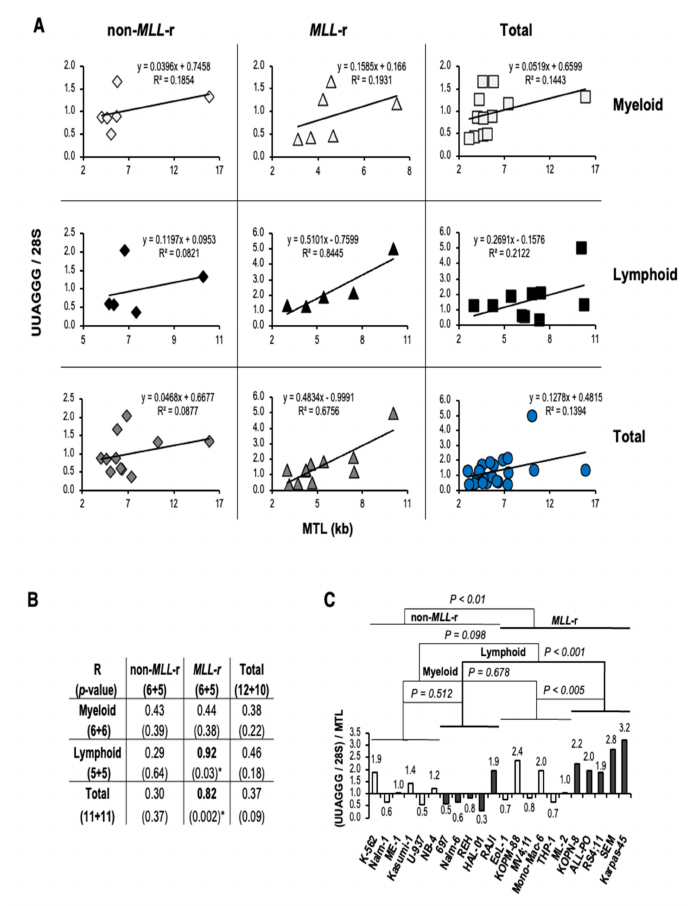
Figure 4. UUAGGG repeat-containing RNA levels in MLL-r ALL correlate with telomere length and reflect increased levels of TERRA. ( A ) Linear correlation analysis between UUAGGG repeat- containing RNA level per transcriptome (UUAGGG/28S) and mean telomere length (MTL) in leukemia cell lines of myeloid and lymphoid lineage carrying ( MLL -r) or not (non- MLL -r) MLL rear- rangements. Best trendline, linear trendline equation, and squared Pearson’s correlation coefficient (R 2 ) are indicated. ( B ) Pearson’s correlation coefficient (R) and relative two-tailed probability value ( p ) from the linear correlation analysis. Statistically significant Pearson’s correlation coefficients are indi- cated in bold (*). ( C ) An estimate of transcriptome-normalized TERRA levels (TERRA/28S) was cal- culated by expressing the UUAGGG repeat-containing RNA level per transcriptome (UUAGGG/28S) relative to MTL. The TERRA/28S level [(UUAGGG/28S)/MTL)] of each cell line was expressed relative to the mean TERRA/28S value in non- MLL -r leukemia. We performed statistical analysis by two-way